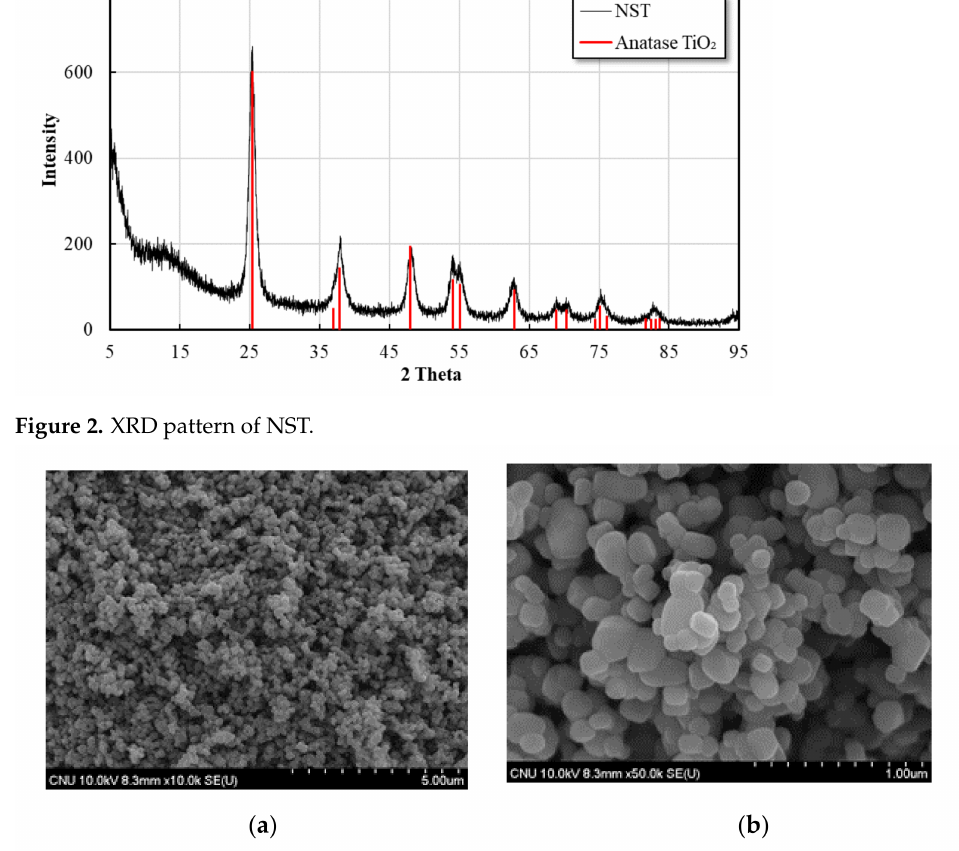
Figure 3. SEM images of NST: ( a ) NST (10,000 × ); ( b ) NST (50,000 × ).